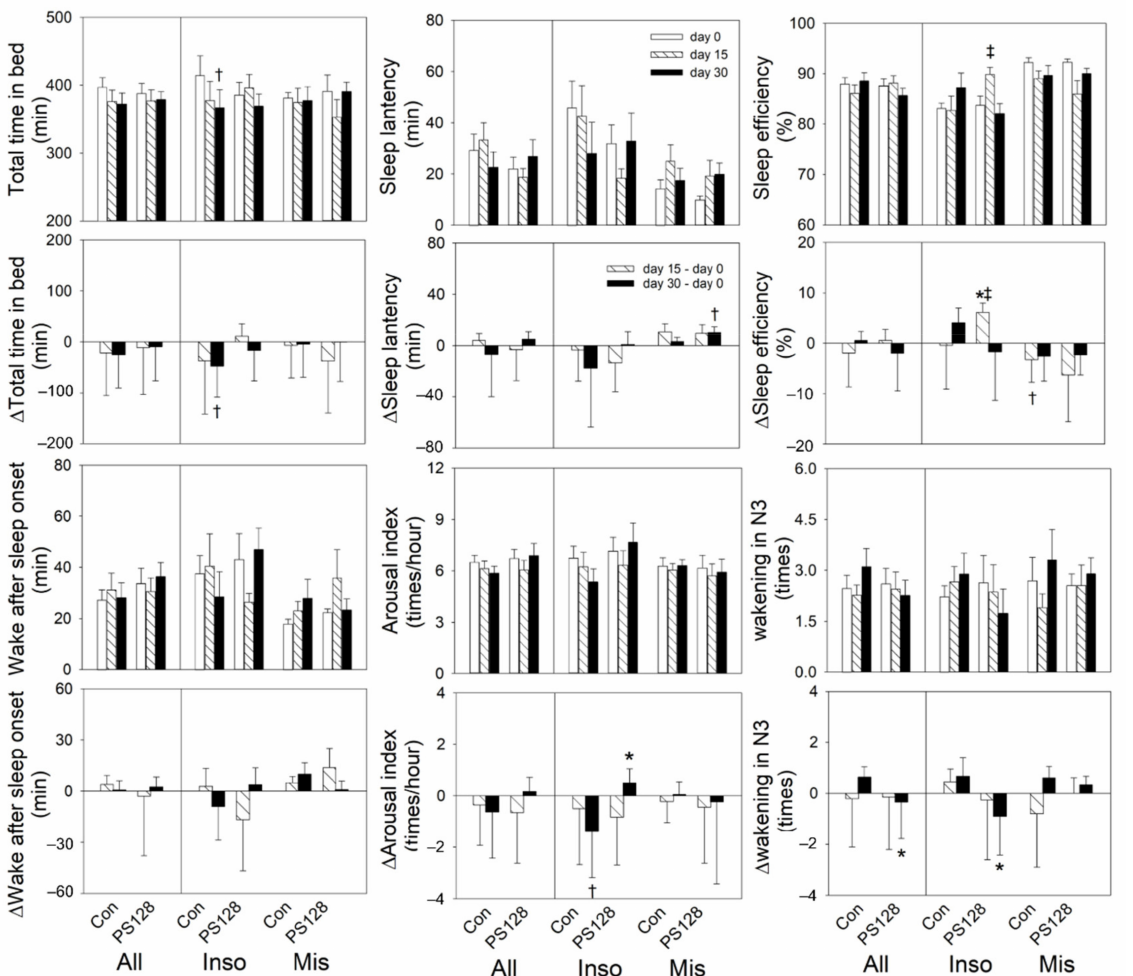
Figure 4. Effects of PS128 on sleep EEG. On day 30, the PS128 group showed significant decreases in awakenings in N3 compared to the control group. † p < 0.05, ‡ p < 0.01 vs. baseline by repeat measurement ANOVA. * p < 0.05 vs. the control group by generalized estimating equations. Values are presented as mean ± SEM. All: Con, n = 19, PS128, n = 21; Inso: Con, n = 9, PS128, n = 12; Mis: Con, n = 10, PS128, n = 9. Con, control; Inso, insomniac; Mis, misperception; N3, non-rapid eye movement sleep stage